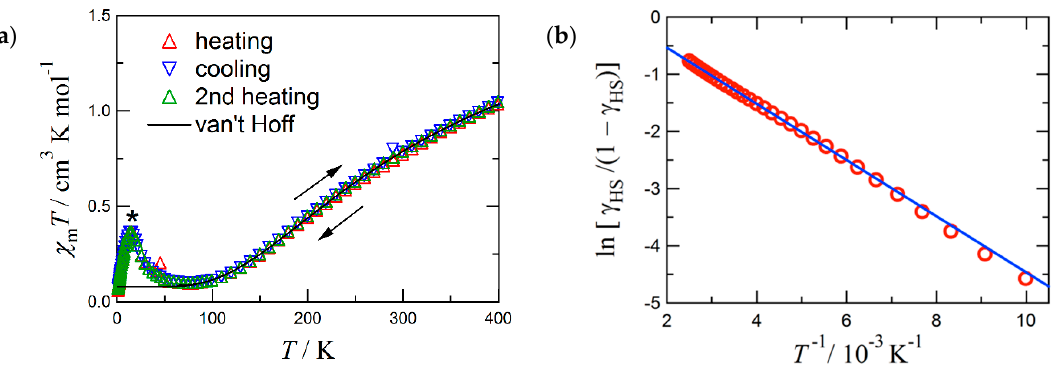
Figure 2. ( a ) The χ m T vs. T plot for 4 . An asterisk indicates an impurity signal. ( b ) van’t Hoff plot of the first heating data above 100 K. The solid lines are calculated with the van’t Hoff equation and optimized parameters (see the text). In ( b ) the intercept is ∆ S / R = 0.447, and the slope is −∆ H / R = − 492 K, where R is the gas constant.